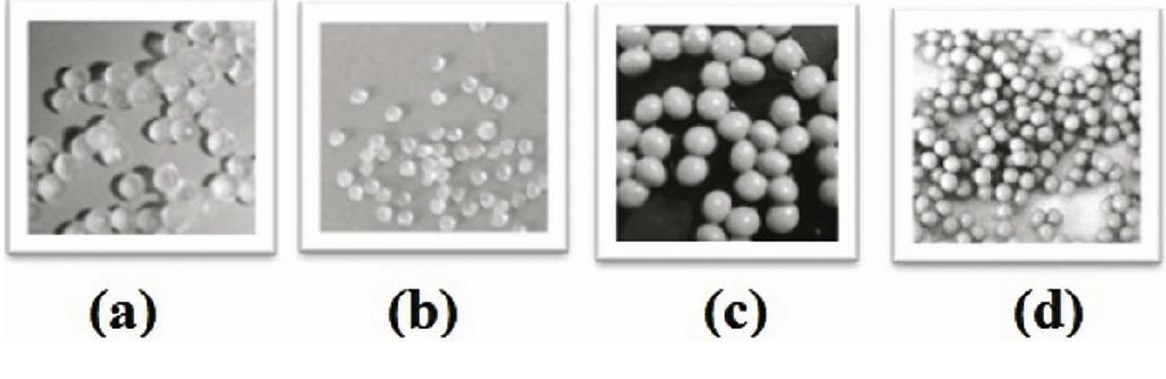
Figure 1. Calcium alginate beads prepared by the dripping technique (the four figures are not at the same ratio); ( a ) the free beads before dehydration (mean diameter = 2.44 mm); ( b ) the free beads after dehydration, (mean diameter = 0.85 mm); ( c ) the berberine beads before dehydration with 88.7% drug loading (mean diameter = 2.98 mm); ( d ) the berberine beads after dehydration with 88.7% drug loading (mean diameter = 2.07 mm).